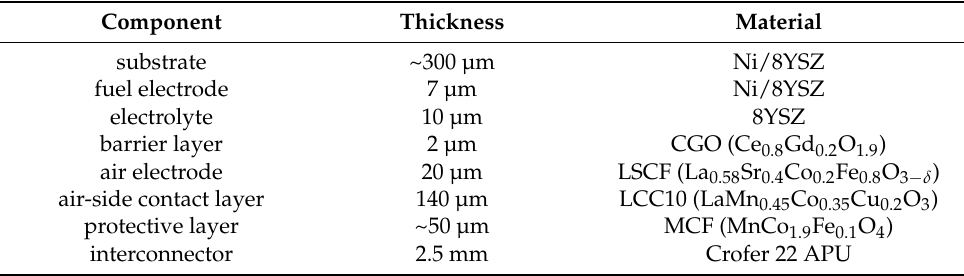
Table 1. Cell and stack components of a repeating